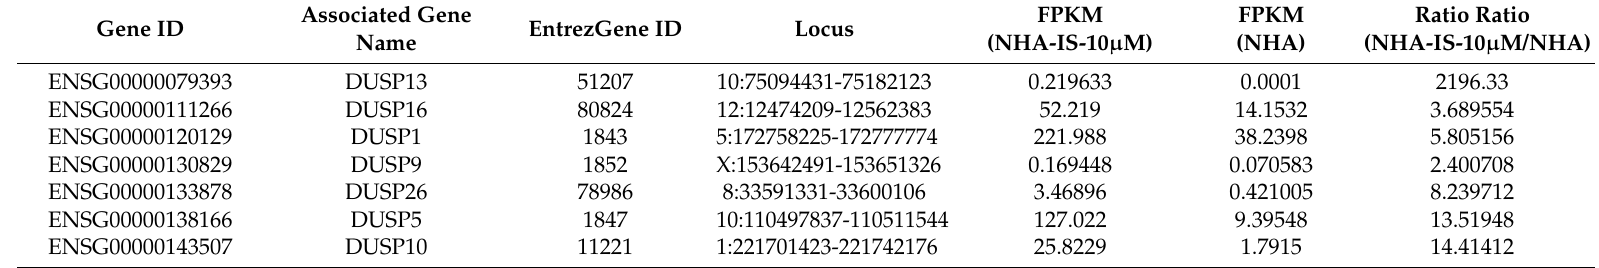
Figure 9. Human astrocytes treated with control or 10 μM IS for various durations (3 h, 6 h, 12 h, and 24 h). The phosphorylated and total protein levels in the cell lysates were assessed with an immunoblot assay. The results shown are representative of three independent experiments performed on different days, along with relative expression levels to the corresponding control groups at the same time point. IS decreased the phosphorylation of ( A ) ERK, ( B ) MEK, ( C ) JNK, and ( D ) p-38 at 12 h treatment in human astrocytes. Data represent mean ± SD of a representative experiment. Table 1. Dual-specificity phosphatase (DUSP) mRNA expression measured by NGS analysis. Under the condition of fragments per kilobase of transcript per million (FPKM) > 5 and fold change > 2. IS increased the expression of DUSP1, DUSP5, DUSP5, and DUSP16 in astrocytes.